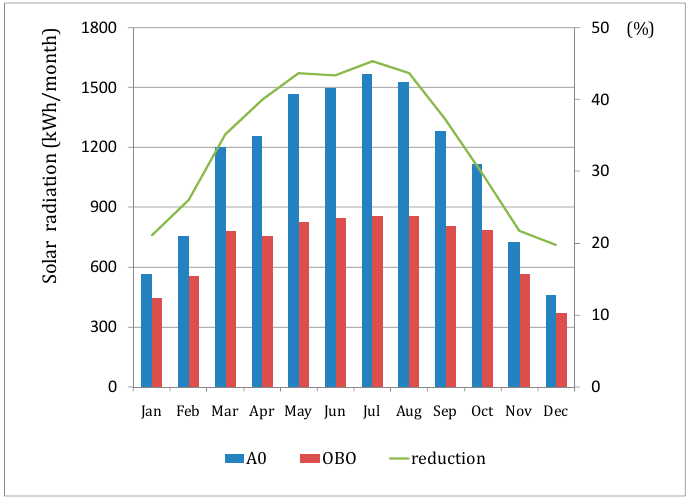
Figure 7. Solar radiation through windows and its reduction in OBO house.